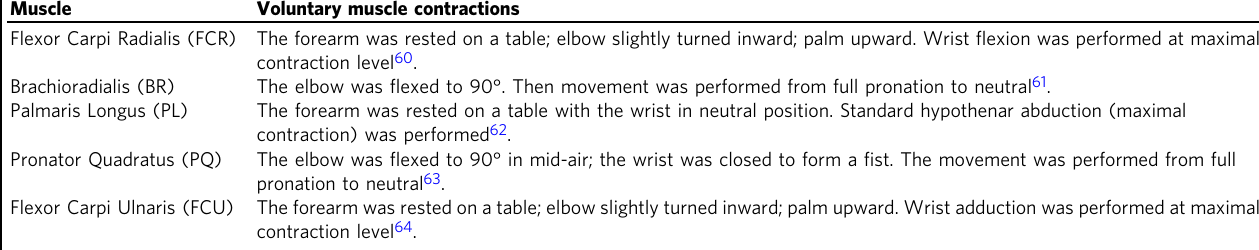
Table 1 Five muscles used for the experimental condition and their corresponding voluntary contraction identi fi ed from literature 35 . Muscle Voluntary muscle